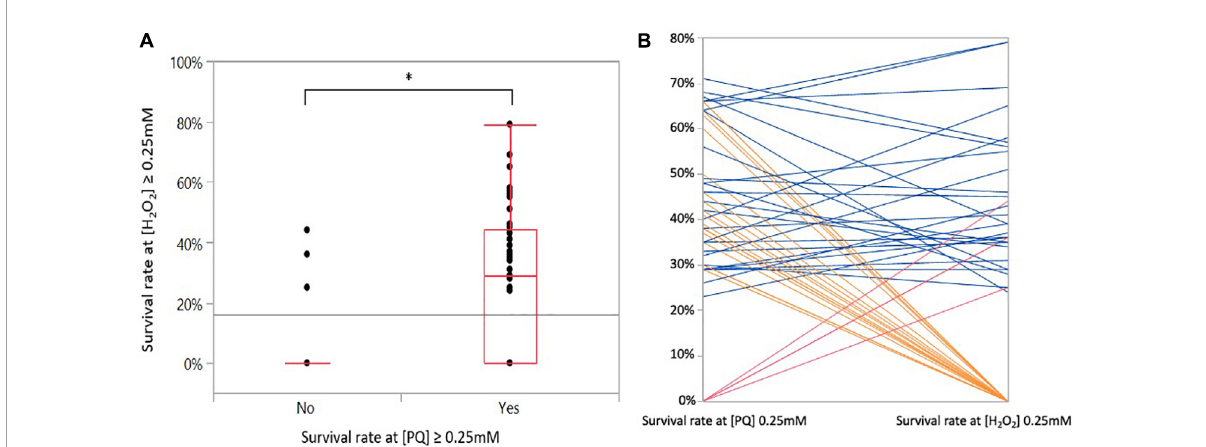
FIGURE2 Correlations between superoxide and hyperoxide stress responses. (A) Survival rate of the 83 C. jejuni strains exposed at 0.25 mM H 2 O 2 as a function of their survival to 0.25 mM PQ. Statistical significance was determined using the ANOVA test ( ∗ p ≤ 0.05). (B) Relationship between survival at 0.25 mM PQ and H 2 O 2 . The parallel coordinates indicate strains that show similar survival responses or not to both stresses. Each line corresponds to a strain exposed to PQ (left y -axis) and to H 2 O 2 (right y -axis). Blue lines correspond to strains surviving both stresses at a concentration of 0.25 mM ( n = 27), orange lines to strains surviving at 0.25 mM of PQ but not at 0.25 mM H 2 O 2 ( n = 20), and red lines to strains surviving at 0.25 mM H 2 O 2 but not at 0.25 mM PQ ( n = 4).